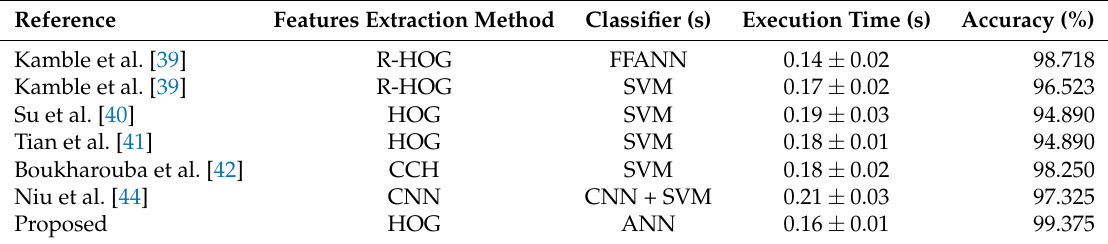
Table 6. Performance comparison with respect to similar existing